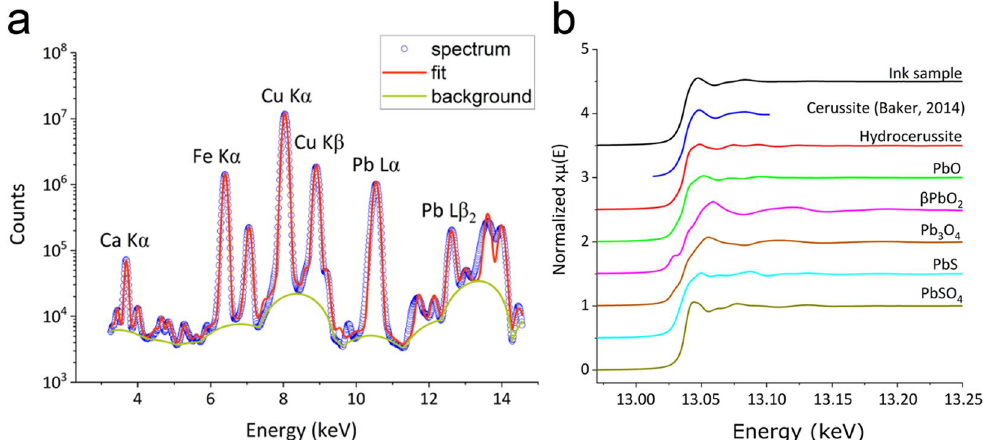
Figure 2. ( a ) SR-XRF average spectrum of the ink sample (experimental: empty blue circle) and its fit obtained with PyMca (red curve); ( b ) Normalized spectra of the ink sample and all the collected XAS data of reference compounds. The cerussite (PbCO 3 ) spectrum is taken from Baker et al 22